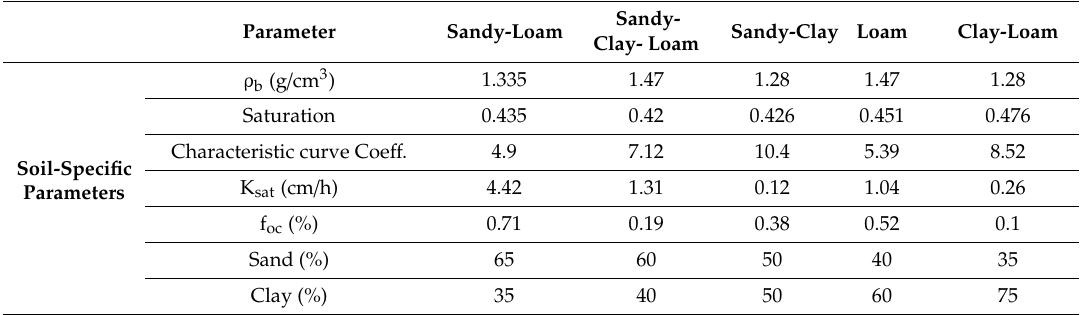
Table 4. Parameter values and characteristics of the different types of soil considered in the simulations.